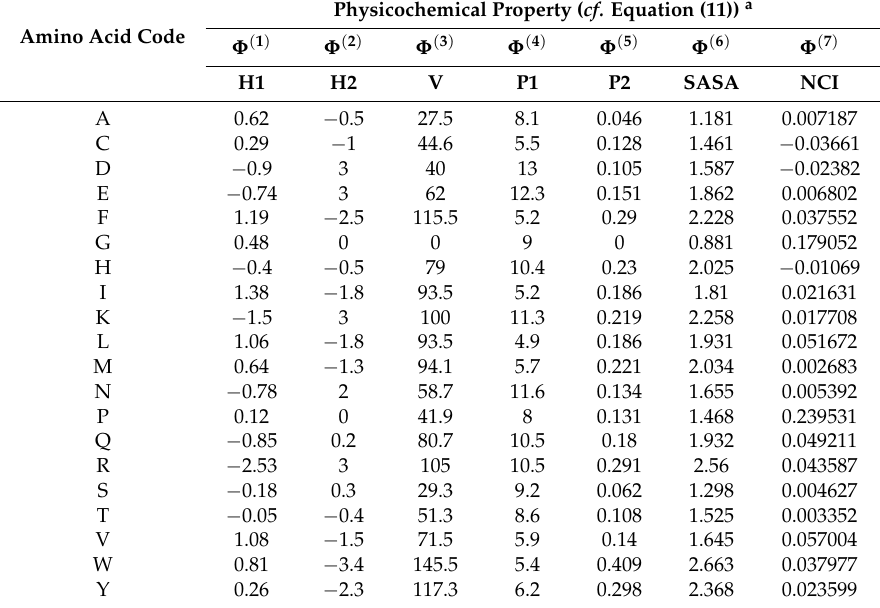
Table 2. The original values of the seven physicochemical properties for each amino acid.